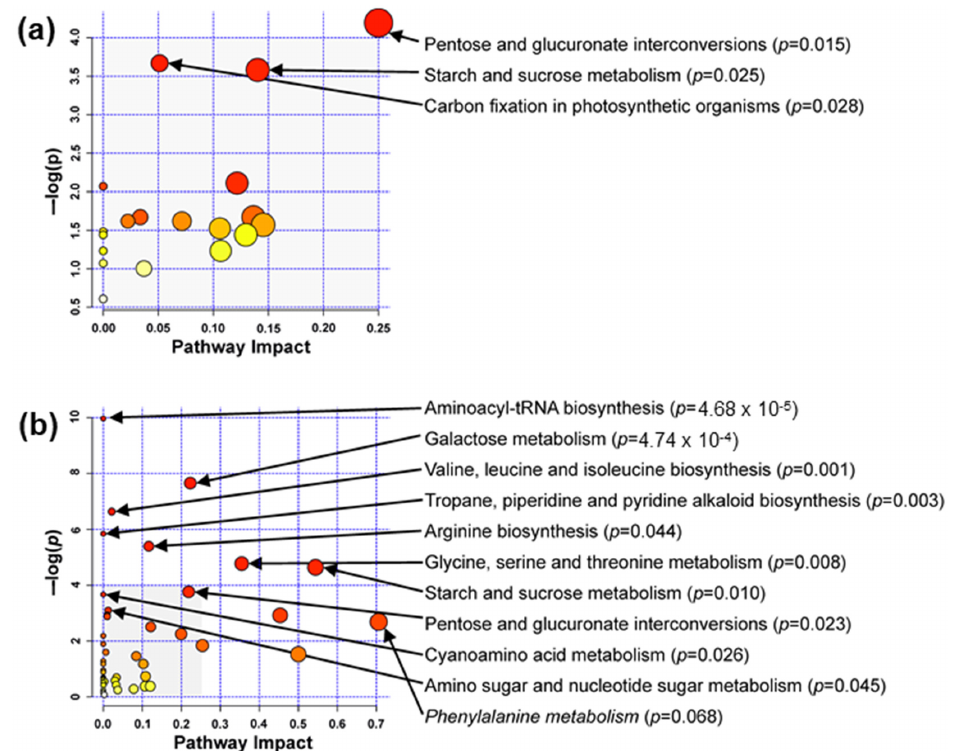
Figure 8. Concentrations of starch ( a ) and soluble carbohydrates ( b ) in the cotyledons. Concentra- tions were calculated as milligrams of glucose per gram of dry weight (DW). Data are the means of